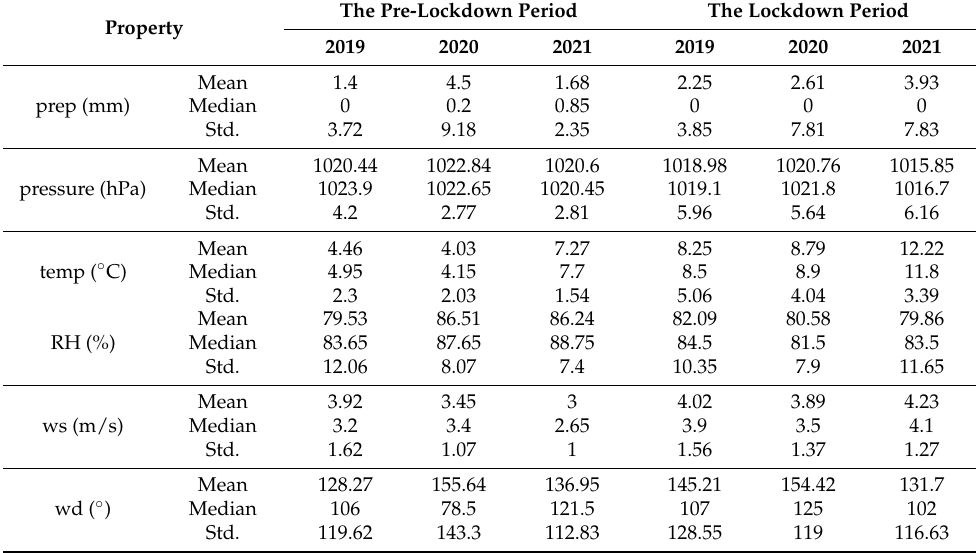
Table 3. Descriptive statistics of meteorological conditions over three years. (prep, pressure, temp, RH, ws, and wd represent precipitation, air pressure, temperature, relative humidity, maximum wind speed and maximum wind direction,